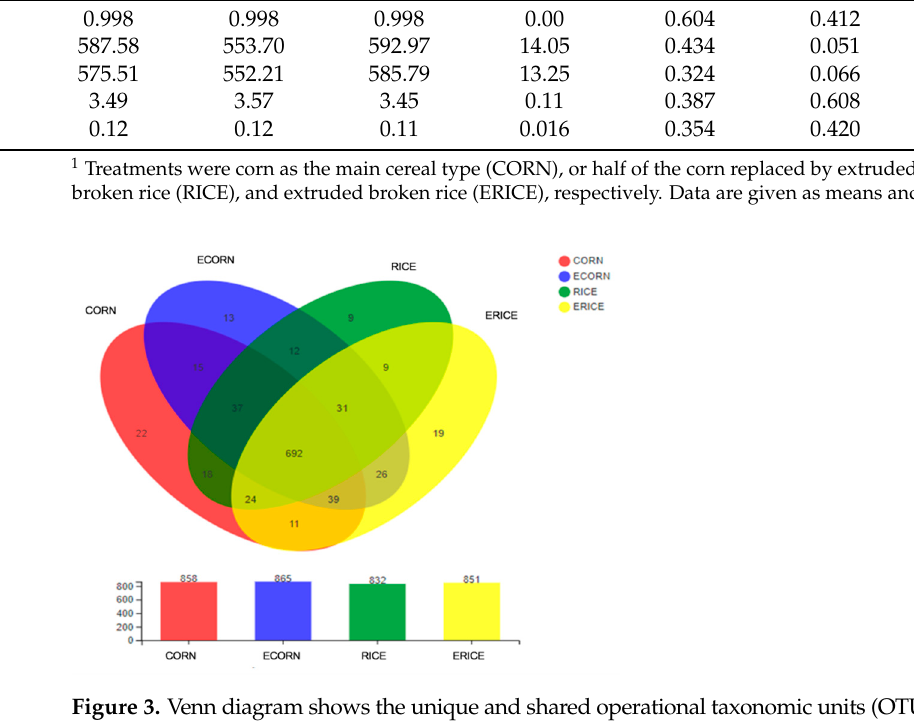
Figure 3. Venn diagram shows the unique and shared operational taxonomic units (OTUs) in different groups at the genus level. Treatments were corn as the main cereal type (CORN), or half of the corn replaced by extruded corn (ECORN), broken rice (RICE), and extruded broken rice (ERICE), respectively.